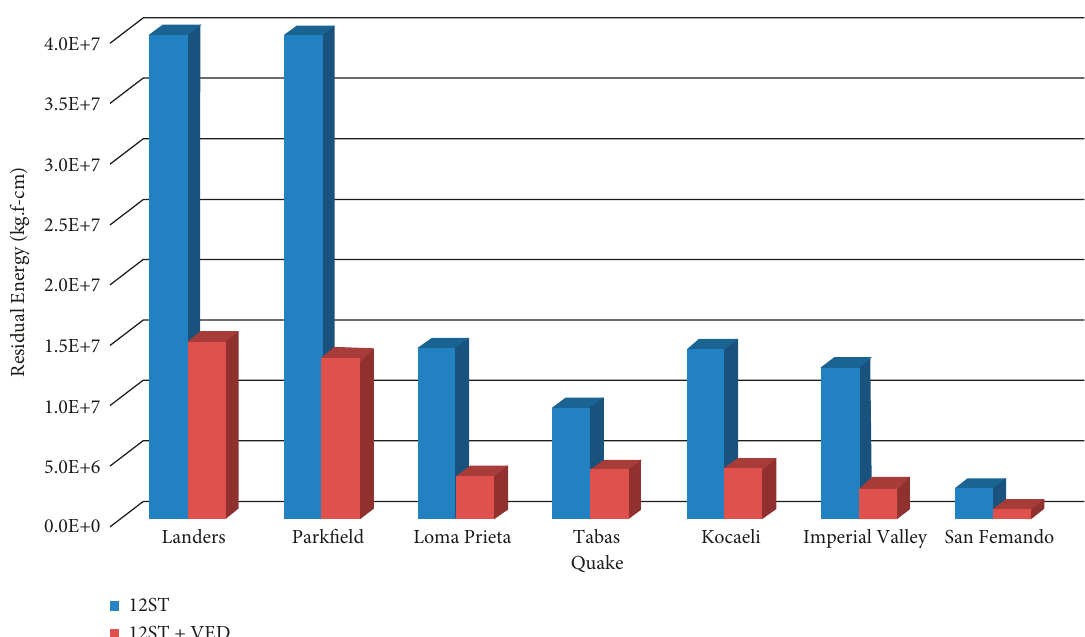
Figure 14: Residual energy diagram in a 12-story frame under near-field records, in two modes with and without dampers.